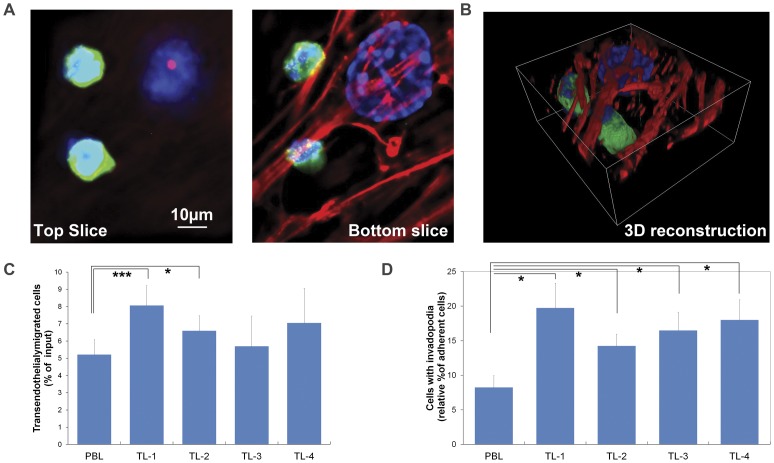
Transendothelial migration and invadopodia assay of the T lymphoma cells.(A) Depicted are two TL cells that had invaded between the endothelial cells. The TL cells were stained with T-cell receptor marker specific anti-CD3 antibodies and the endothelial cells were stained with DAPI and TRITC-Phalloidin. The top panel shows representative Z stack images of the top slice (above the endothelial cells) and the arrow indicates pseudopod formation (B) Transendothelial migration assay of T lymphoma cells. Three dimensional reconstructions showing two TL cells that had invaded the confluent endothelial monolayer. Z stacked images taken at 0.5 µm intervals have been used for reconstruction of the 3D image. (C) The percentage of trans-endothelial migrated T-lymphoma cell lines. The mean and the standard error are shown for 5 experiments (D) Percentage of cells that showed a leading edge pseudopod structure beneath the bEND.3 cells. The mean and the standard error of mean are shown for 4 experiments in which more than 200 cells were analyzed per experiment. (*p<0.05, **P<0.01, ***P<0.001 and ****P<.0001 by Student t test).